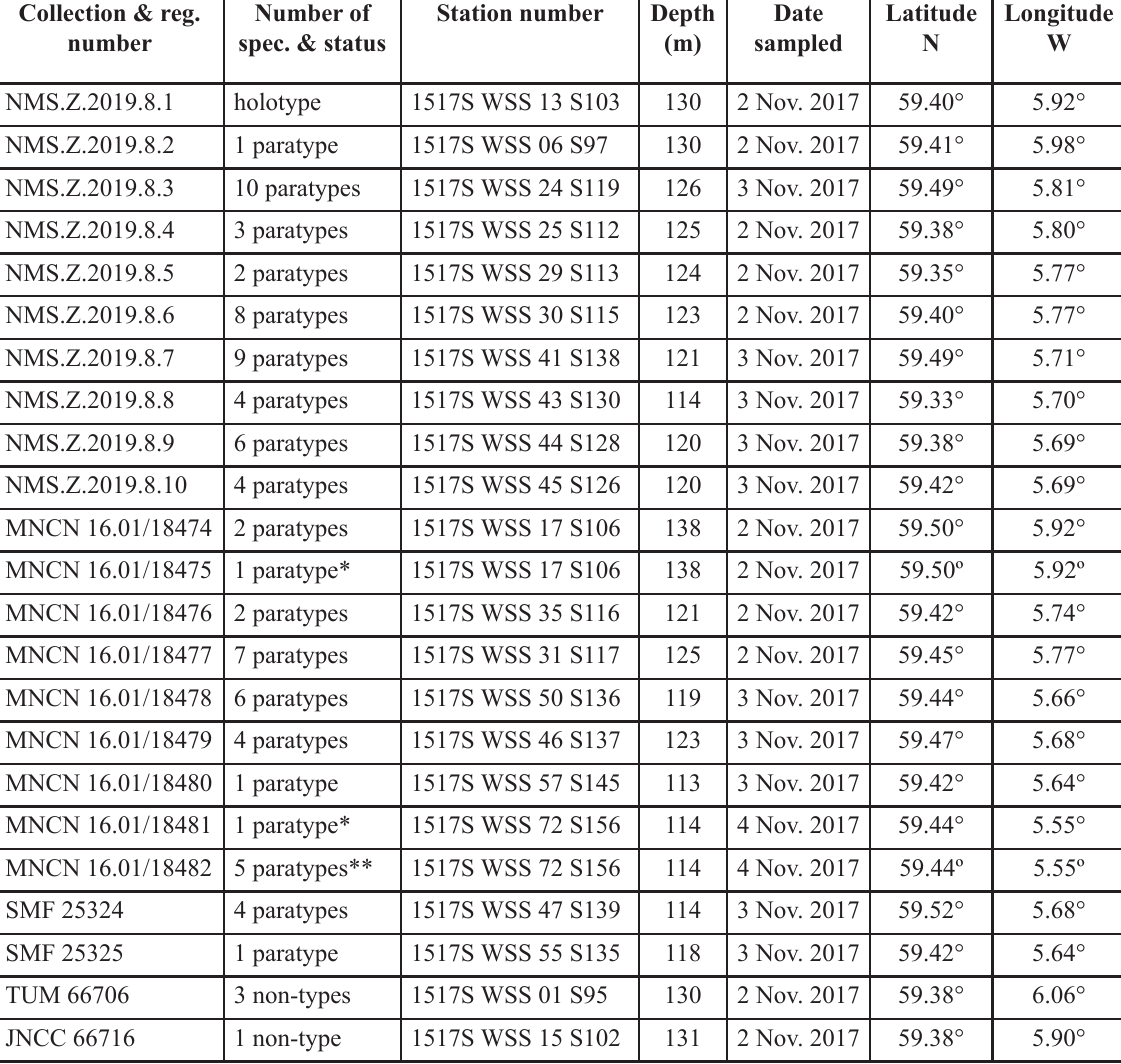
Table 1. Type material and sampling localities of Ampharete oculicirrata sp. nov. Paratypes marked with (*) are females with eggs and with (**) are mounted on SEM